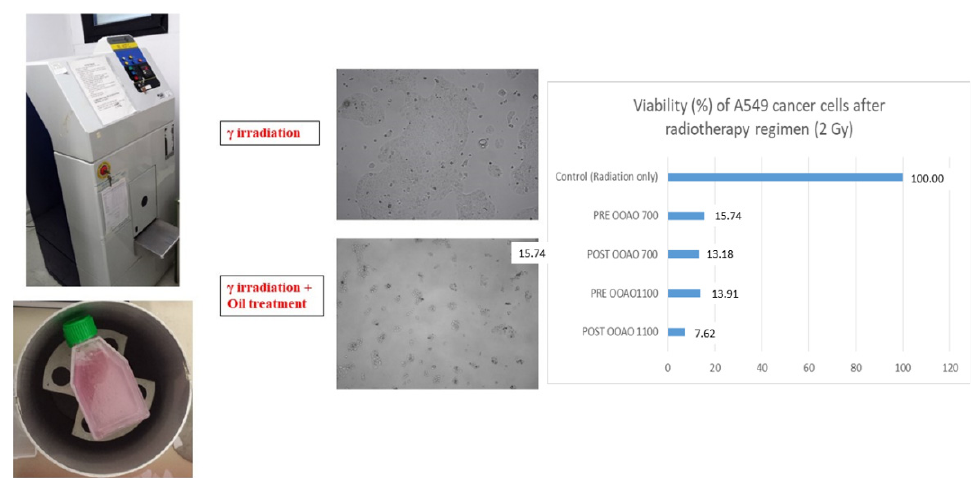
Figure 11. Synergism between gamma ray radiation and ozonized oils (OOAO) treatments in killing lung cancer cells.